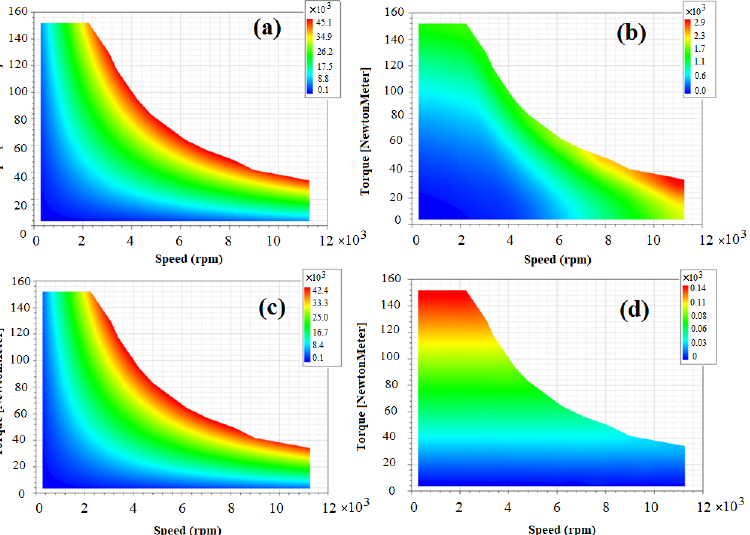
Figure 14. The simulation results of ( a ) input power map, ( b ) loss map, ( c ) output power map and ( d ) output torque map.